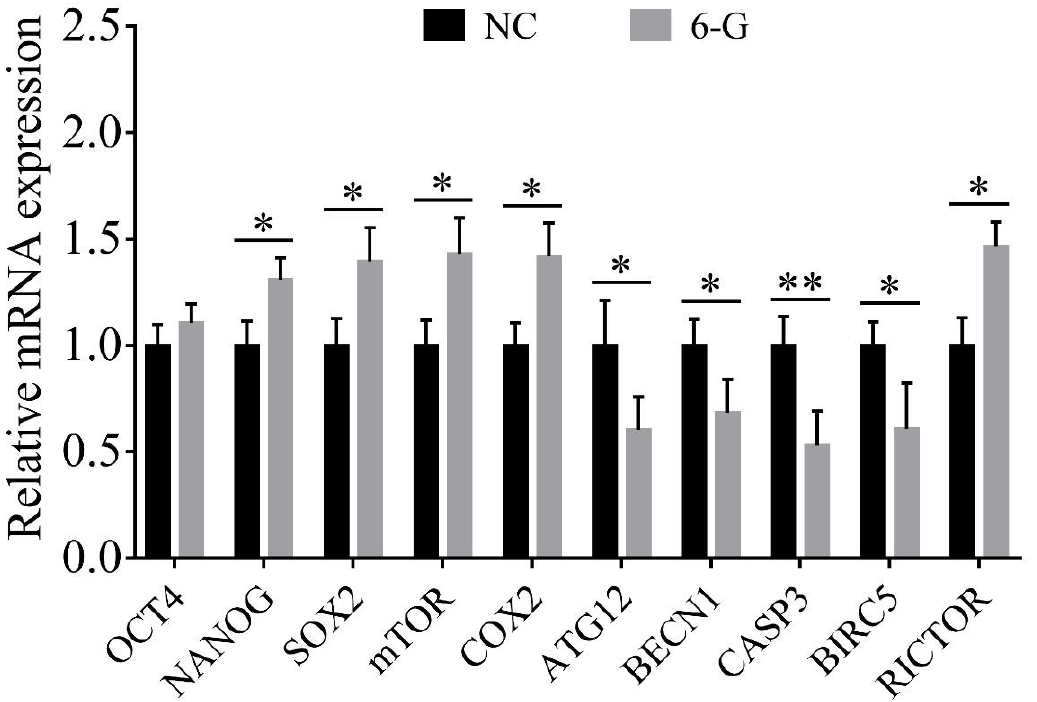
Figure 7. Results of quantitative real-time reverse transcription polymerase chain reaction (qRT-PCR) analysis of functional gene expression. Expression of embryo pluripotency- ( OCT4 ; NANOG ; and SRY-box transcription factor 2, SOX2 ), proliferation- (mechanistic target of rapamycin kinase, mTOR ), hatching (cytochrome c oxidase subunit II, COX2 ), apoptosis- (RPTOR independent companion of MTOR complex 2, RICTOR ; caspase 3, CASP3 ; and baculoviral IAP repeat containing 5, BIRC5 ), and autophagy- (autophagy related 12, ATG12 ; beclin 1, BECN1 ) related genes were all detected in blastocysts at day 7. R = 3. * p < 0.05; ** p <